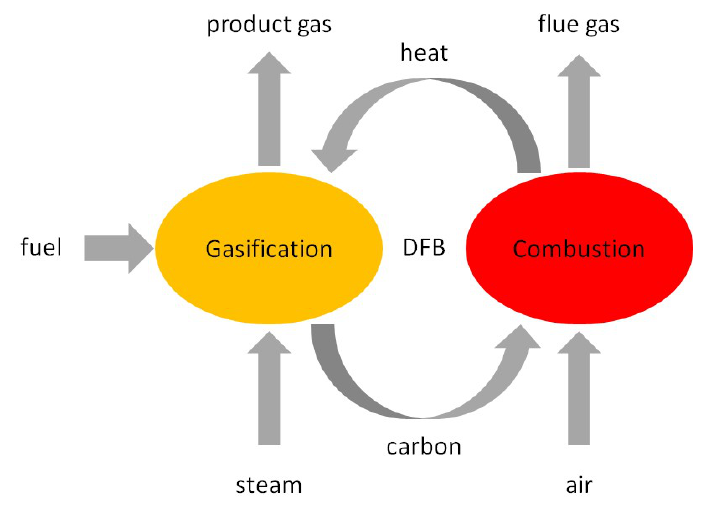
Figure 4. Principle functionality of the dual fluidized steam gasification process.